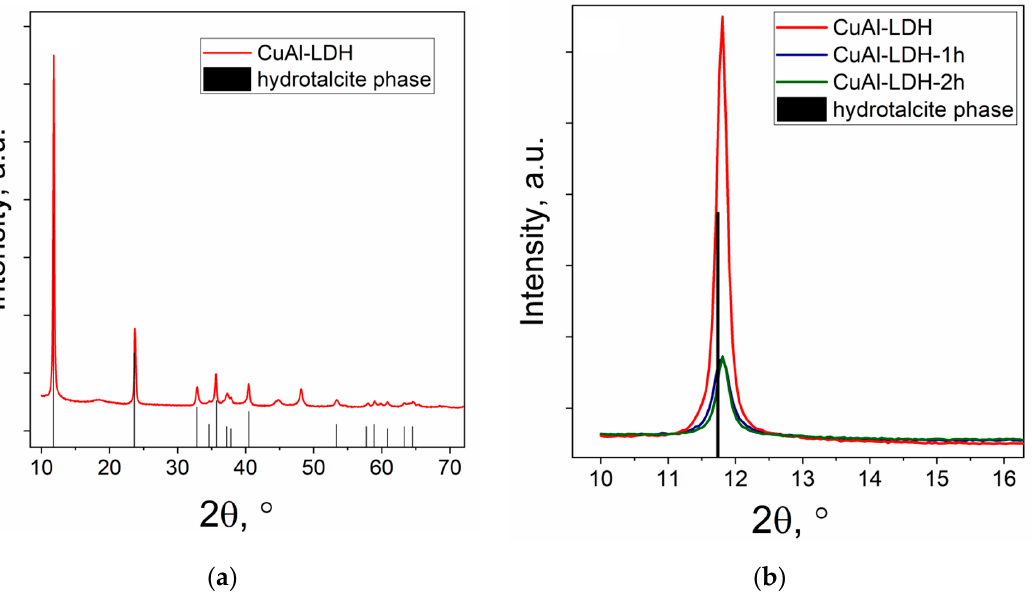
Figure 2. XRD patterns of ( a ) CuAl-LDH and ( b ) CuAl-LDH, CuAl-LDH-1h and CuAl-LDH-2h in low-angle region.